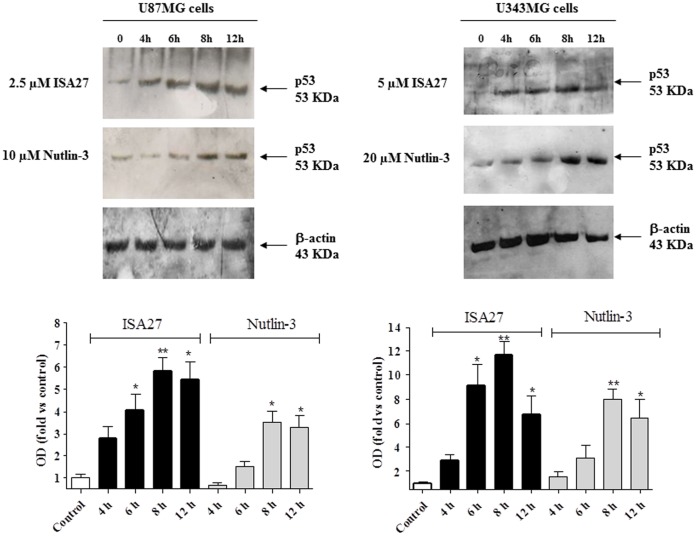
ISA27 increases p53 protein levels in GBM cell lines.GBM cells (U87MG, U343MG) were treated with ISA27 or Nutlin-3 for the indicated incubation times, and protein levels of p53 were analysed in whole-cell lysates by Western blot. One representative Western blot is presented (upper panel) for each cell line. The blots show that the antibody to p53 (FL-393; Santa Cruz Biotechnology) recognised a single specific band at approximately 55 kDa, corresponding to the molecular weight of the p53 protein; β-actin is used as the loading control. Densitometric analyses of Western blots (lower panel) demonstrated that ISA27 induced a significant enhancement of p53 protein levels in U87MG or U343MG cells with a maximal effect at the 8 h incubation time.